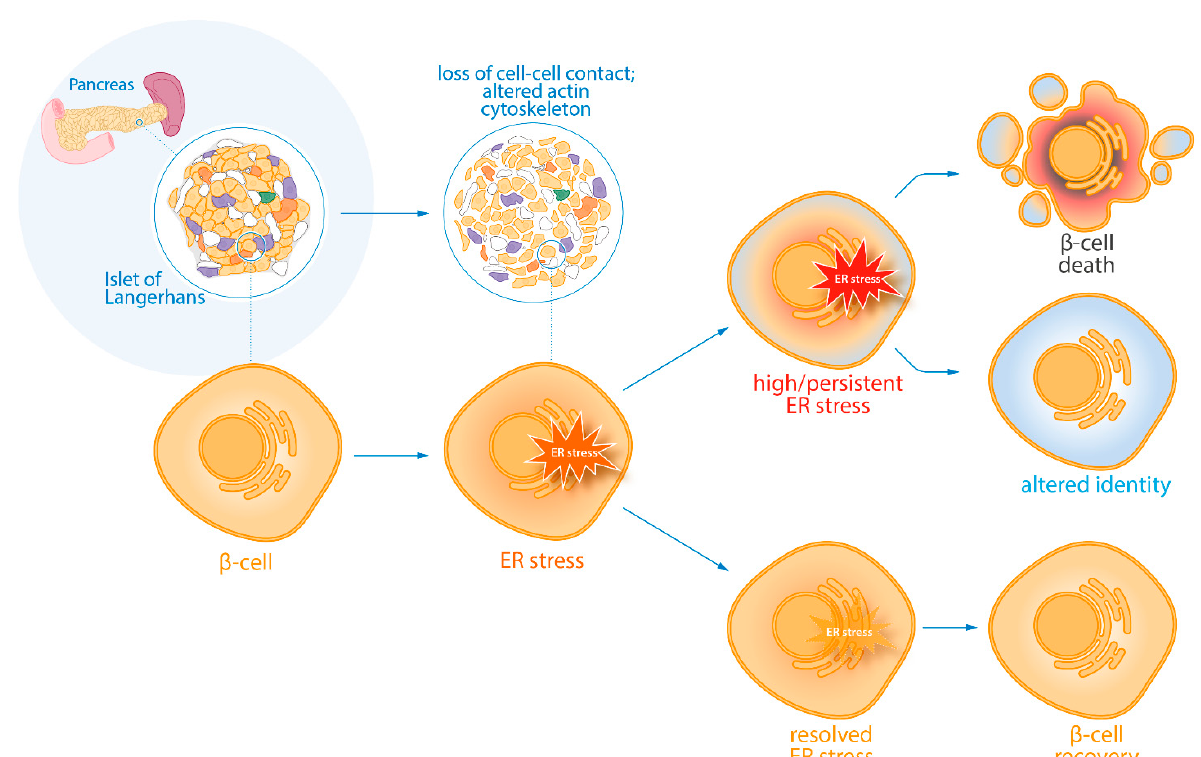
Figure 5. Proposed model. We present a model in which ER stress occurs as a result of the loss of cell-cell contact (in this particular experimental setup) and the subsequent remodelling of the actin cytoskeleton. When ER stress is resolved, the β -cell can fully recover. However, high or persistent ER stress can lead to either β -cell death or altered β -cell identity, thereby leading to a reduced functional β -cell mass. Overall, we propose β -cell identity changes as a cell-intrinsic mechanism to survive irremediable cellular stress. This adaptation mechanism may contribute to the development of diabetes.